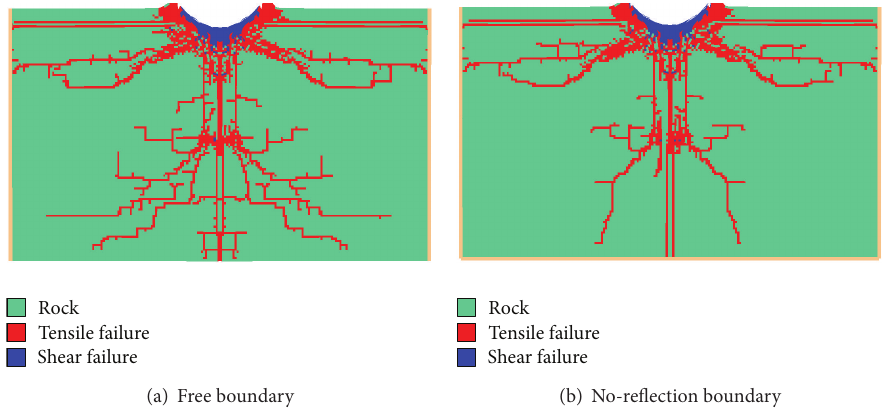
Figure 10: Rock fragmentation status with free and no-reflection boundaries.